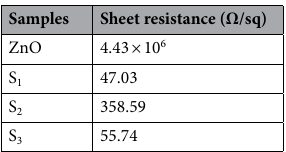
Table 1. Sheet resistance of samples.